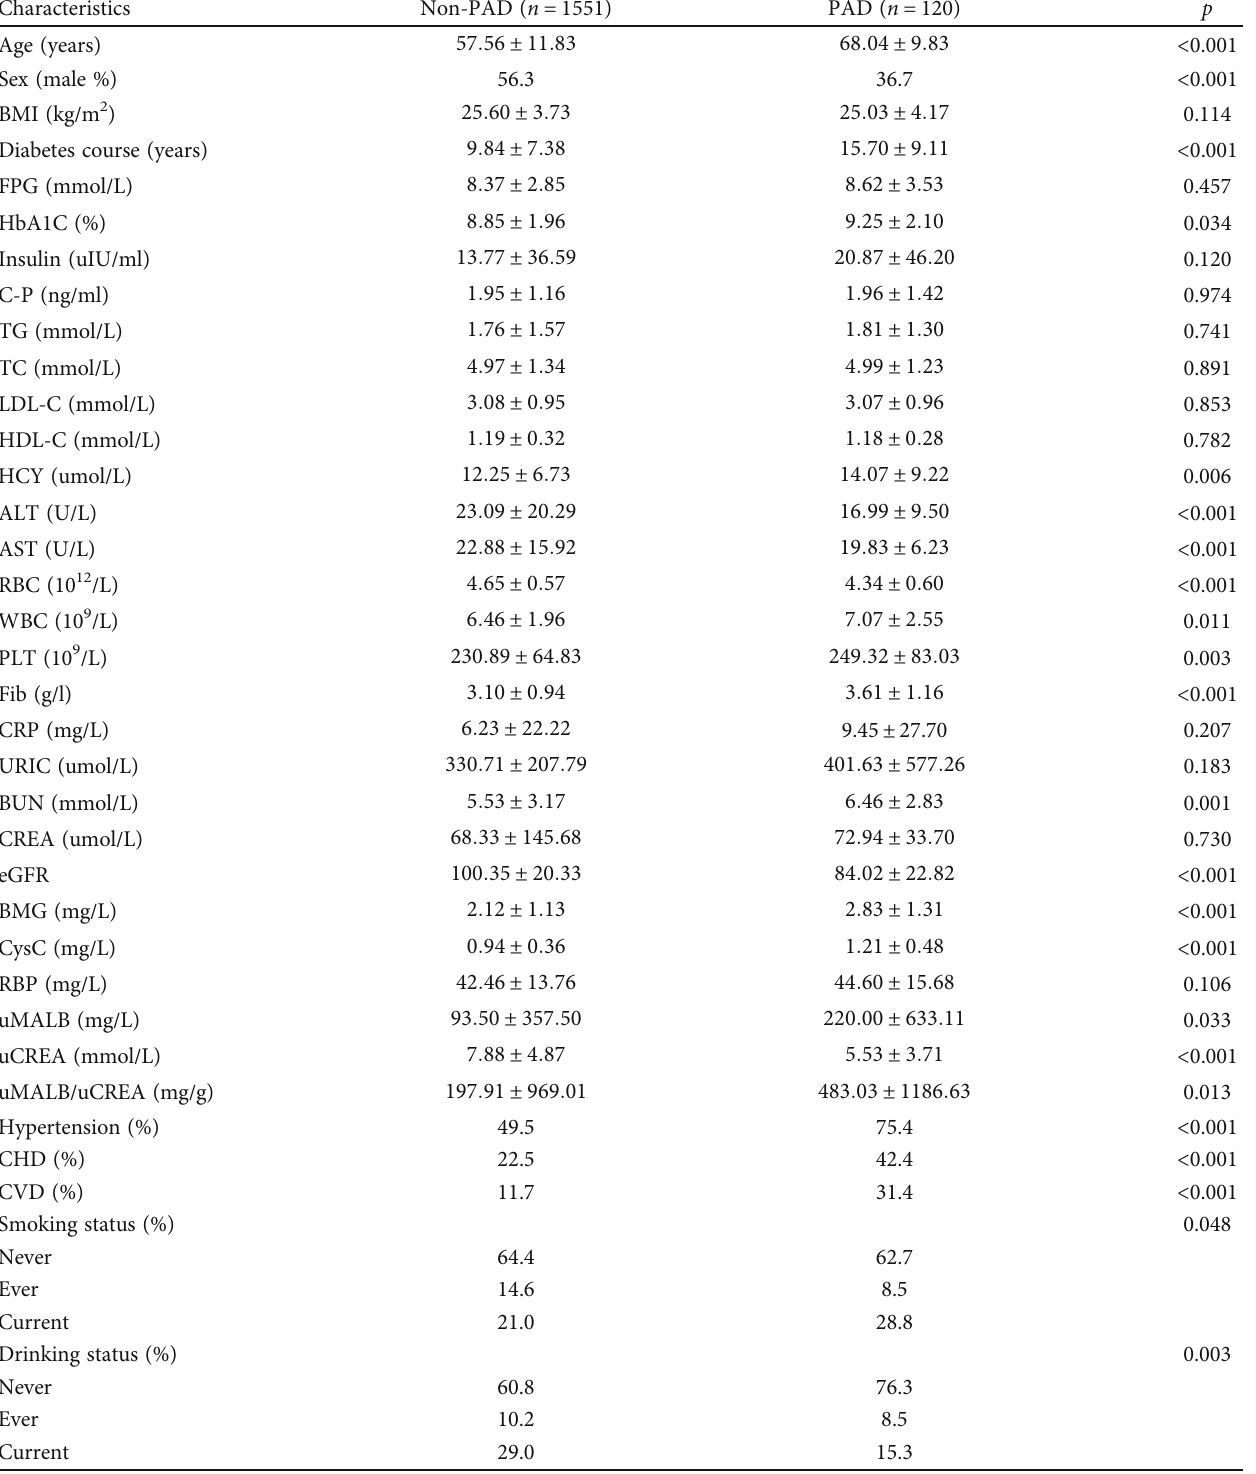
Table 1: Baseline characteristics of studied